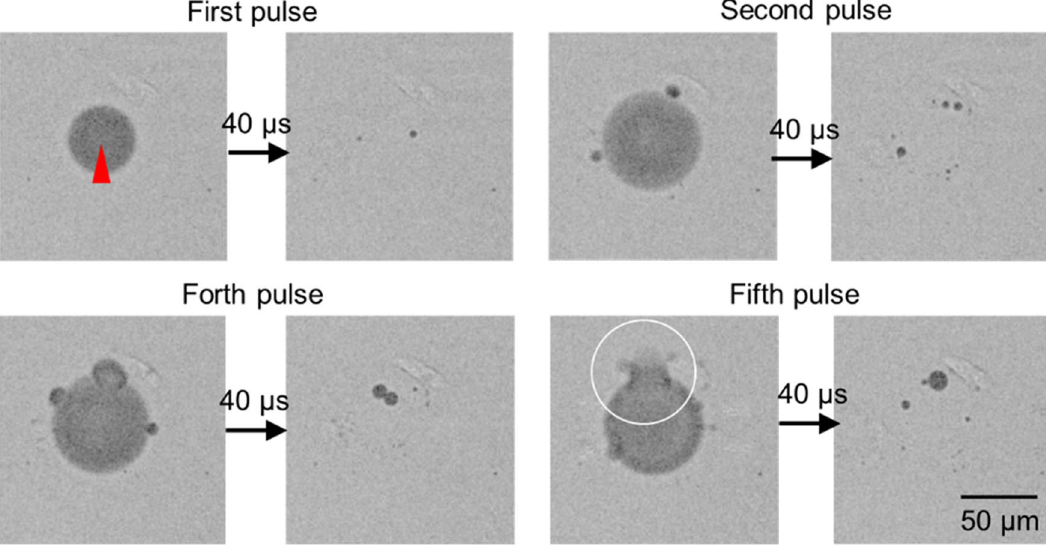
Figure 4. High speed transmission images of cavitation and gas bubble interactions by sequential pulse irradiations at 1 kHz. The images after 1st, 2nd, 4th, 5th pulse were selected. The red triangle indicates the laser focal point. A white circle shows the gas bubble burst after arriving the fifth